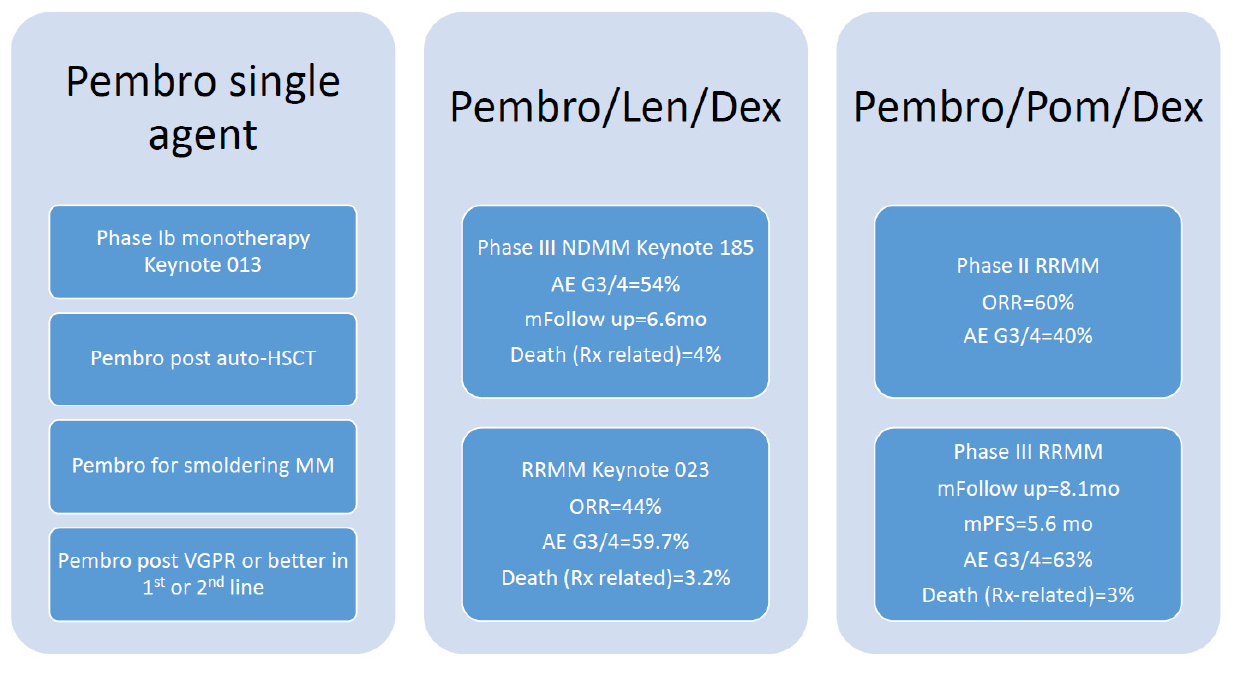
Figure 1. Summary of clinical trials for pembrolizumab in multiple myeloma.